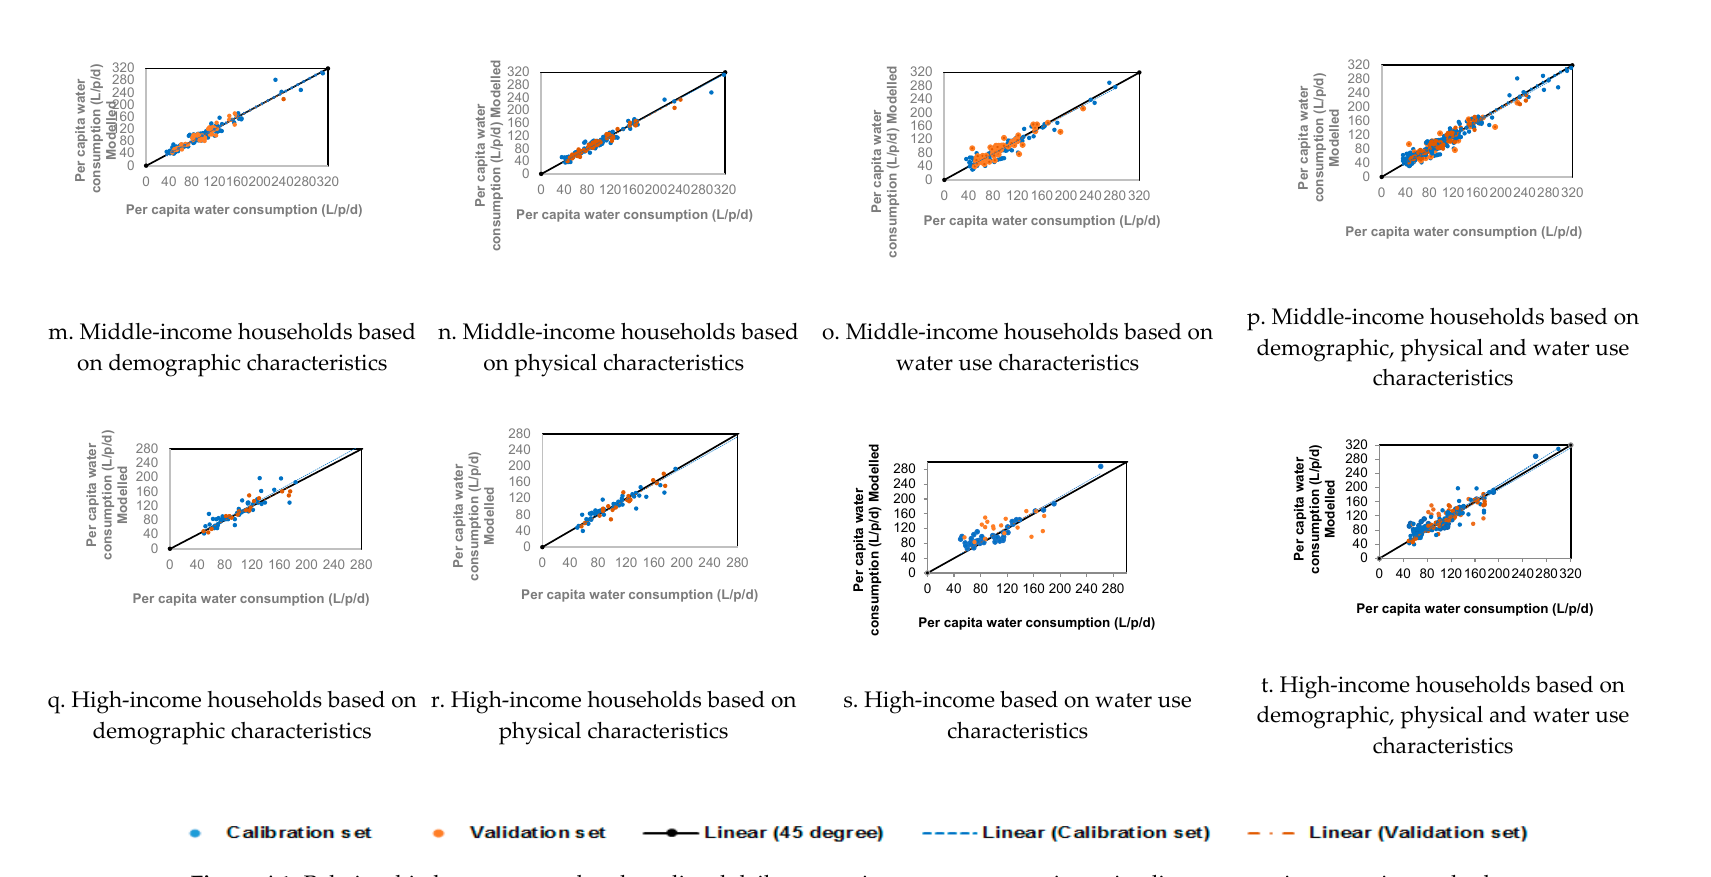
Figure A1. Relationship between actual and predicted daily per capita water consumption using linear regression stepwise method.